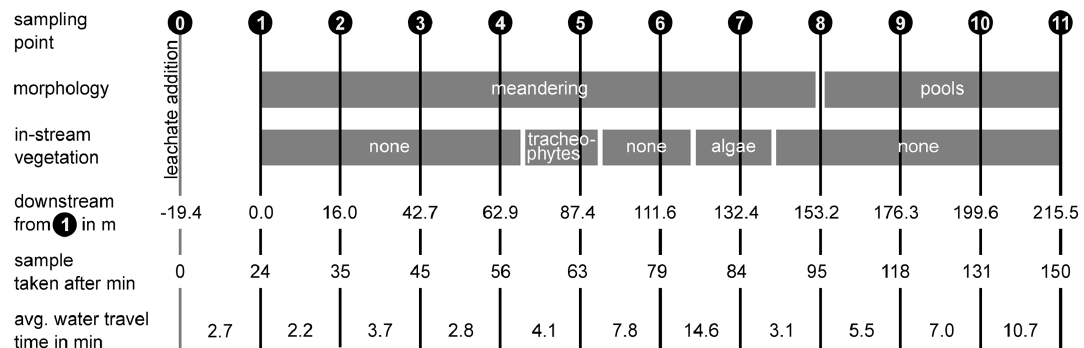
Figure 2. Sampling scheme and general parameters of the stream. Point 0 marks the location of the solute addition, and points 1–11 the sampling